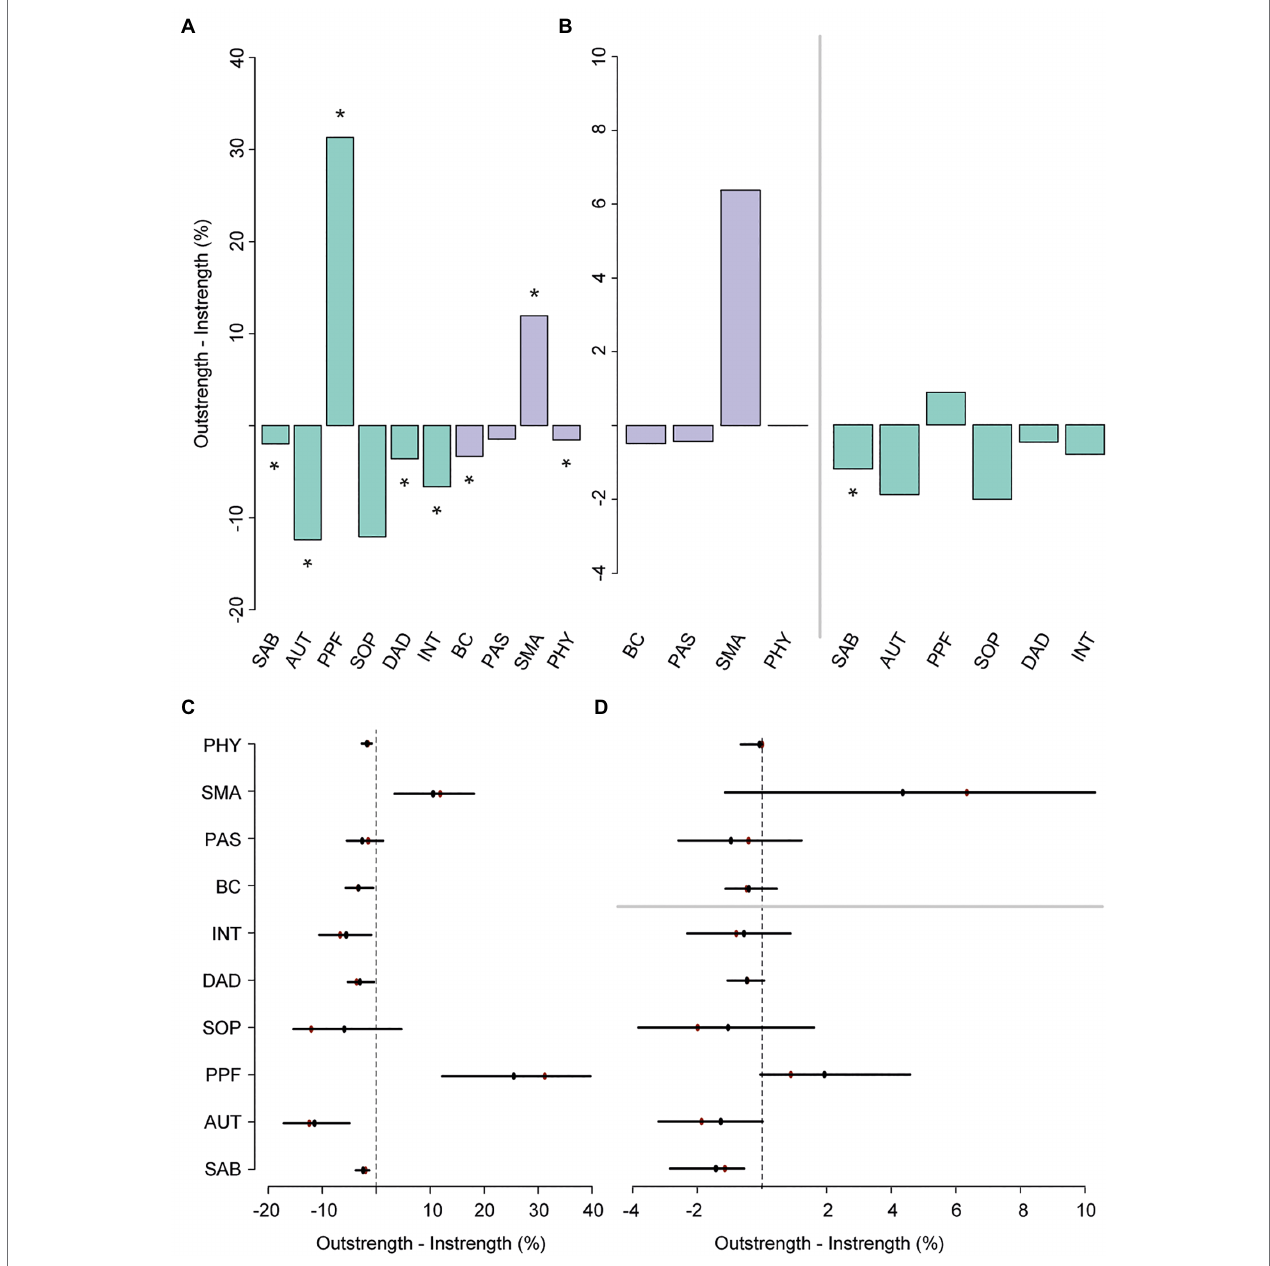
FIGURE 4 | The difference, including bootstrapped quantile intervals, between total outstrength and instrength of all the nodes in the secondary network (A,C) , and the difference in total outstrength and instrength of the relationships between the resilience factors and QoL facets only ( B , left; D , top), and the relationships between the QoL facets and the resilience factors ( B , right; D , bottom). Colors of the bar charts correspond to the nodes in the network in Figure 3 . In plots (C,D) , the bootstrapped mean is depicted in black and the sample mean in red. * p < 0.05, nodes with quantile intervals containing zero are deemed to have an insignificant instrength and outstrength